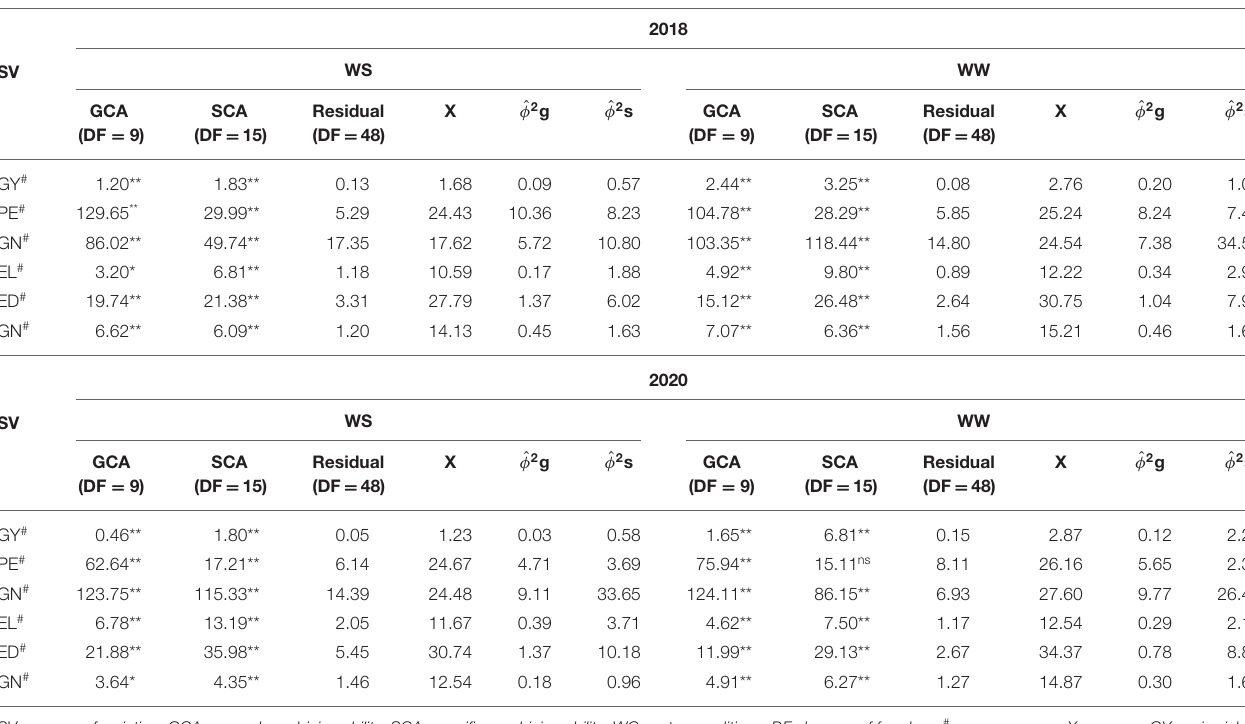
TABLE 5 | Mean squares estimates of popcorn genotypes for GCA and SCA and the residual and mean squares of combining ability effects on agronomic traits in distinct water conditions (WCs) and crop seasons (CSs).